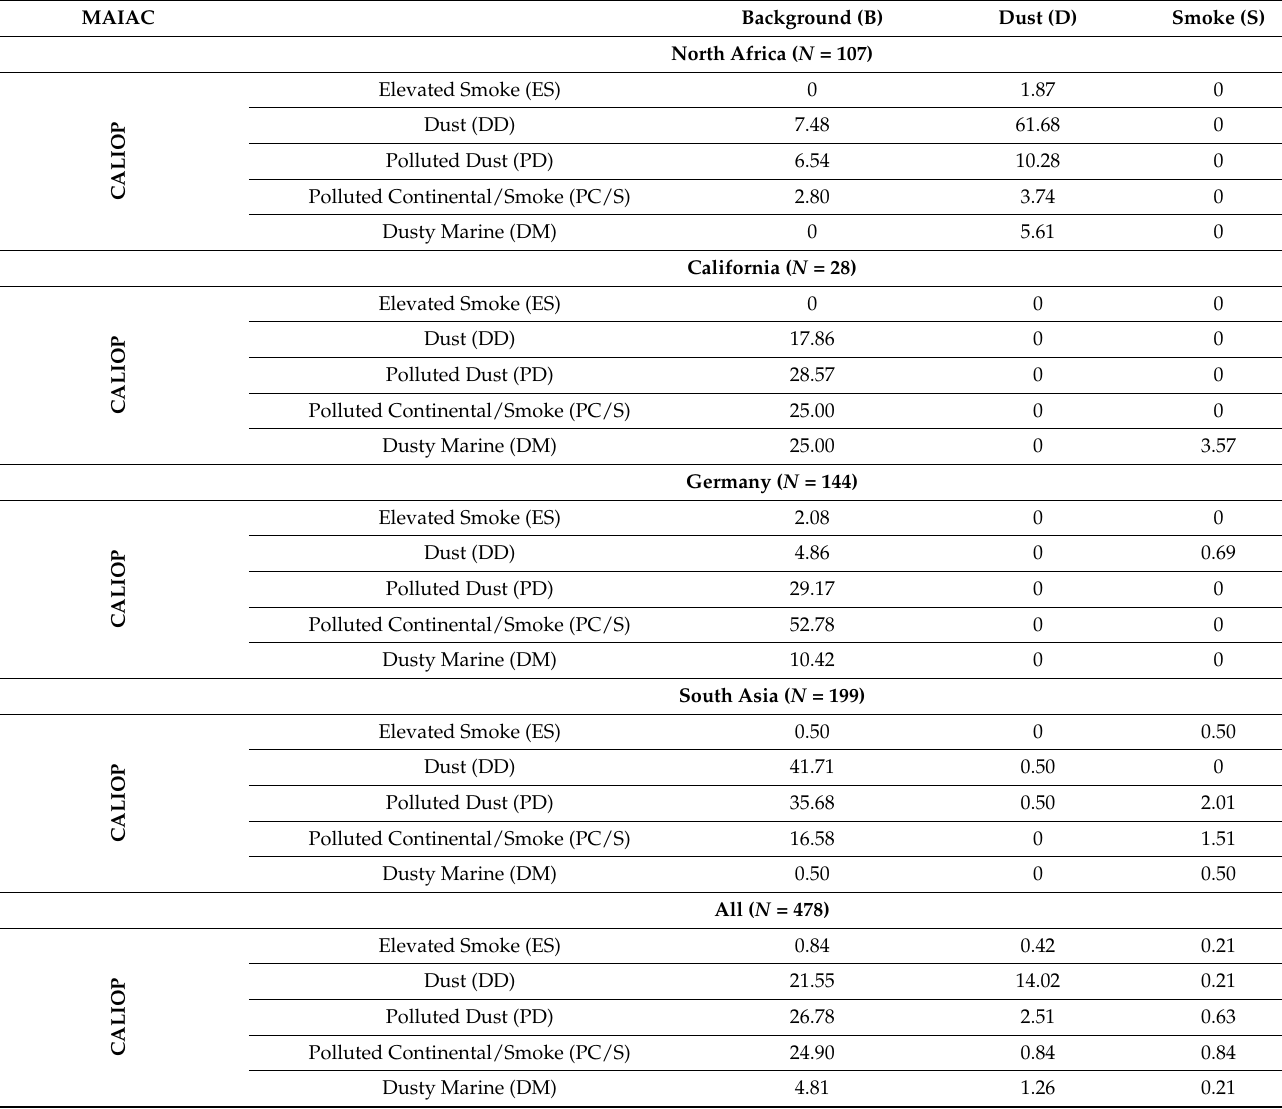
Table 2. Confusion matrixes of aerosol types retrieved by CALIOP and MAIAC (%).